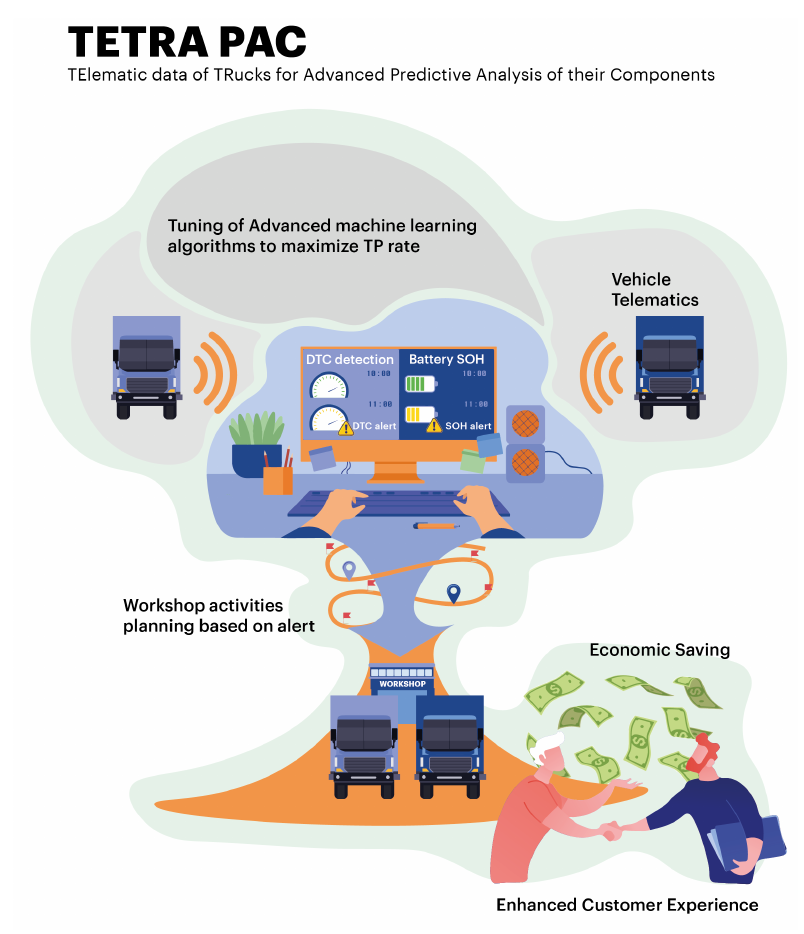
Figure 1. The TETRAPAC overview.